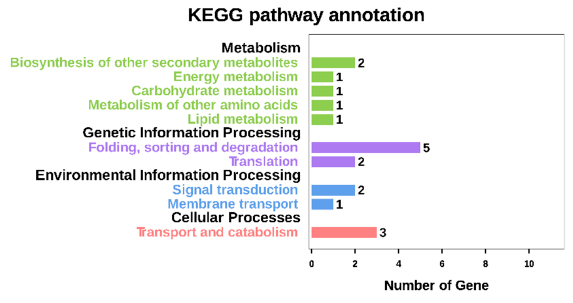
Figure 6. KEGG functional classification of DEGs for QCL5013 vs. QCL8004_1 and QCL5013 vs. QCL8004_2. X axis means number of DEGs. Y axis represents second KEGG pathway terms. All second pathway terms are grouped in top pathway terms indicated in different colors.